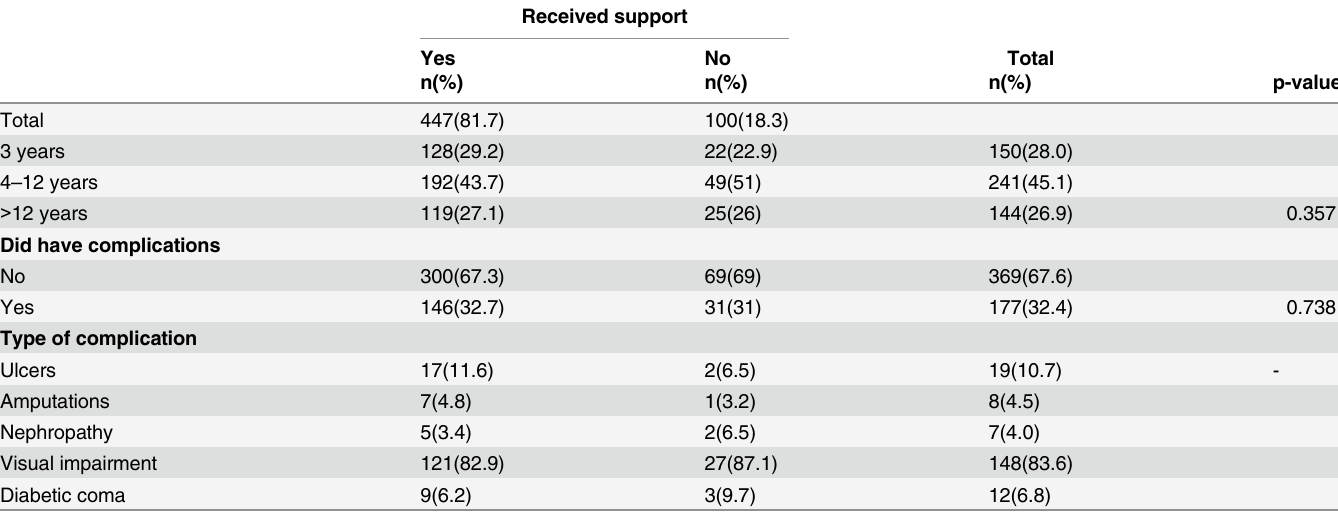
Table 3. Time elapsed after diagnosis of diabetes and complications of the disease.